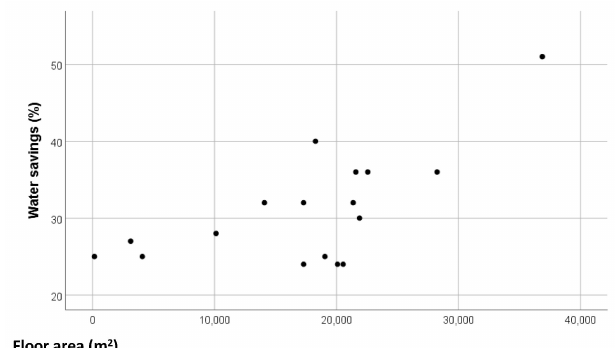
Figure 6. Water savings per floor area.